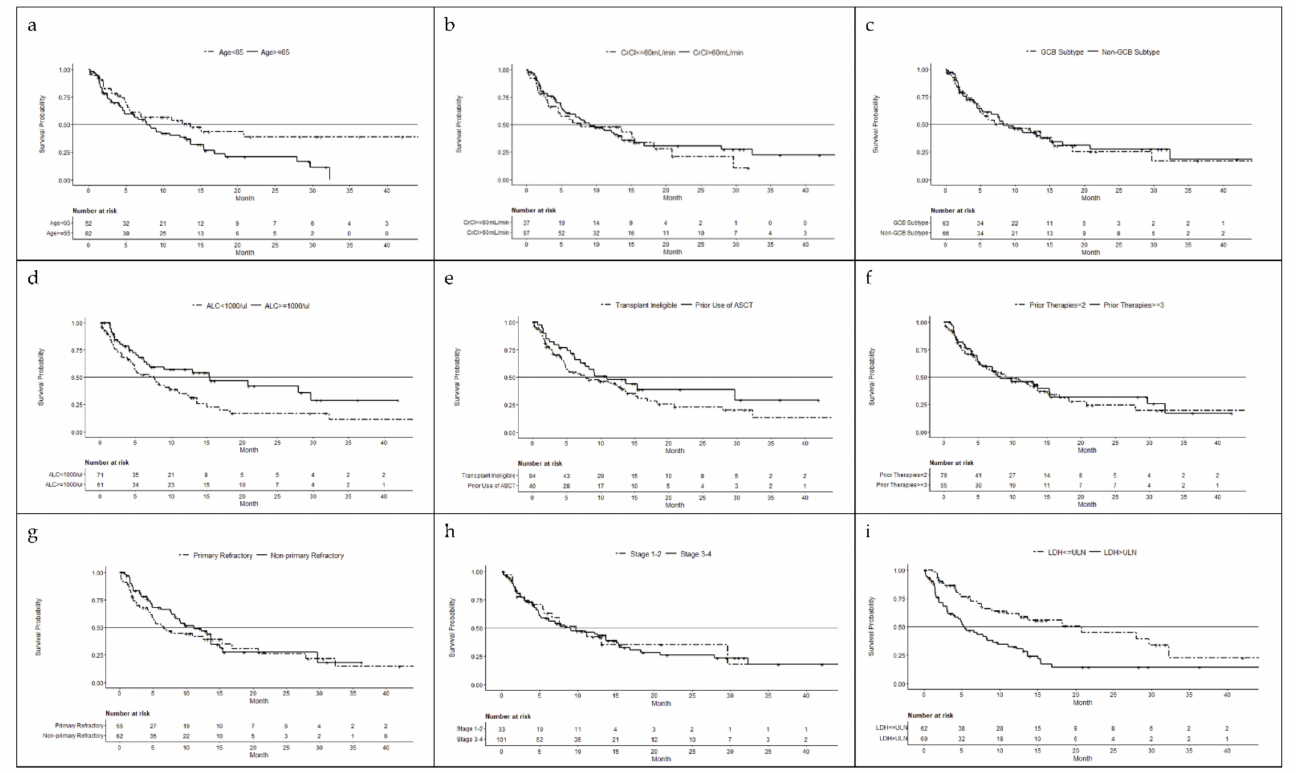
Figure 1. Kaplan–Meier estimated overall survival based on baseline characteristics: ( a ) age, <65